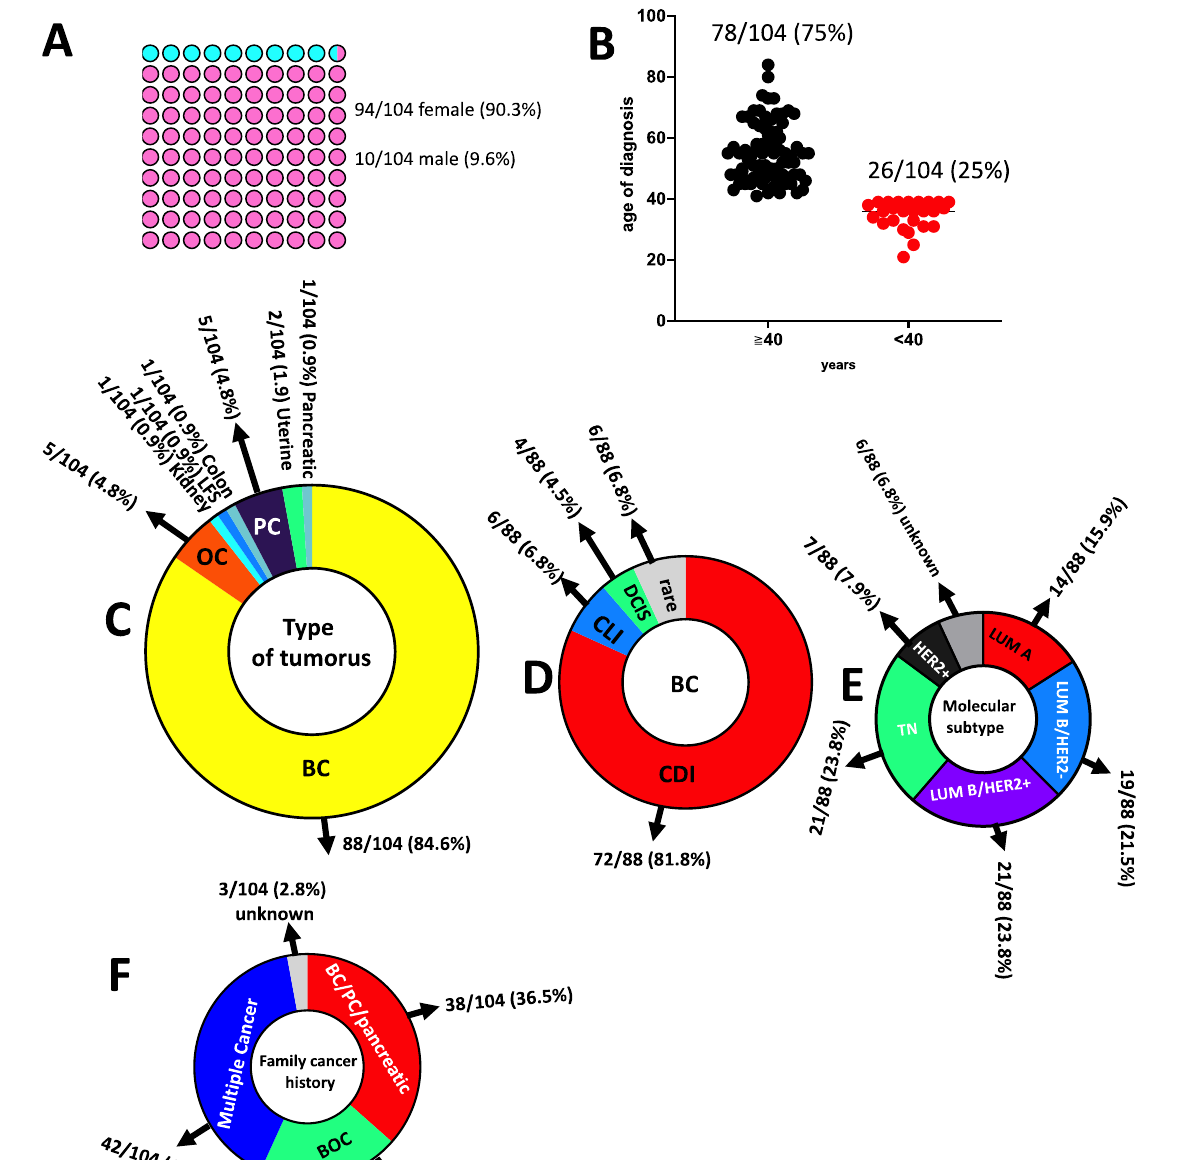
Figure 3. Characteristics of study participants. ( A ) Sex distribution. ( B ) Age of diagnosis. ( C ) Type of tumours. ( D ) BC histology. ( E ) BC molecular subtype. ( F ) Family cancer history; BC: breast cancer; BOC: breast and ovarian cancer; PC: prostate cancer; OC: ovarian cancer; TN: triple-negative; CDI: invasive ductal carcinoma; CLI: invasive lobular carcinoma; DCIS: ductal carcinoma in situ; LUM: luminal; LFS: Li–Fraumeni syndrome.